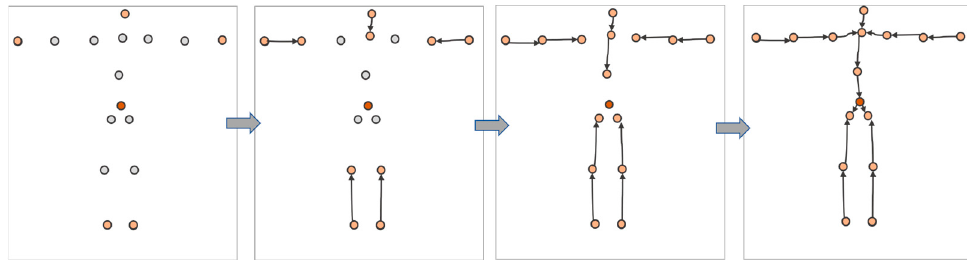
Figure 1. Illustration of hierarchical regression based on kinematic tree. The process of sequentially generating the joint pose parameters is shown as white becomes a warm color.